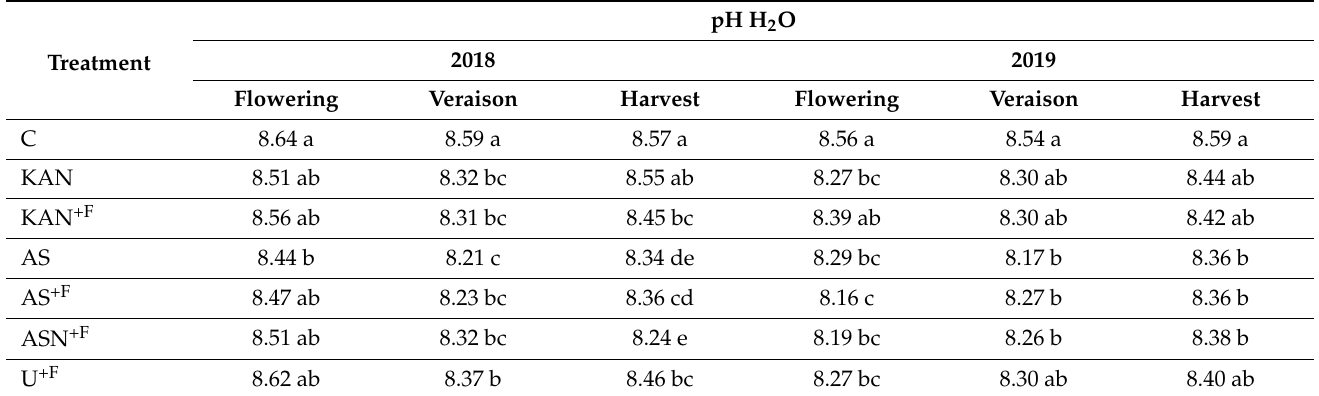
Table 5. Influence of nitrogen fertilization on the actual soil acidity (pH H 2 O).